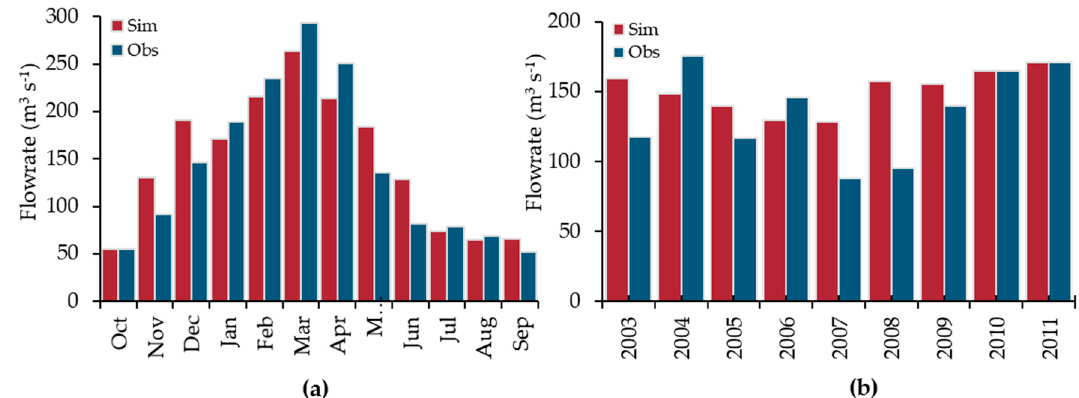
Figure 9. Monthly observed and simulated flowrate time series.